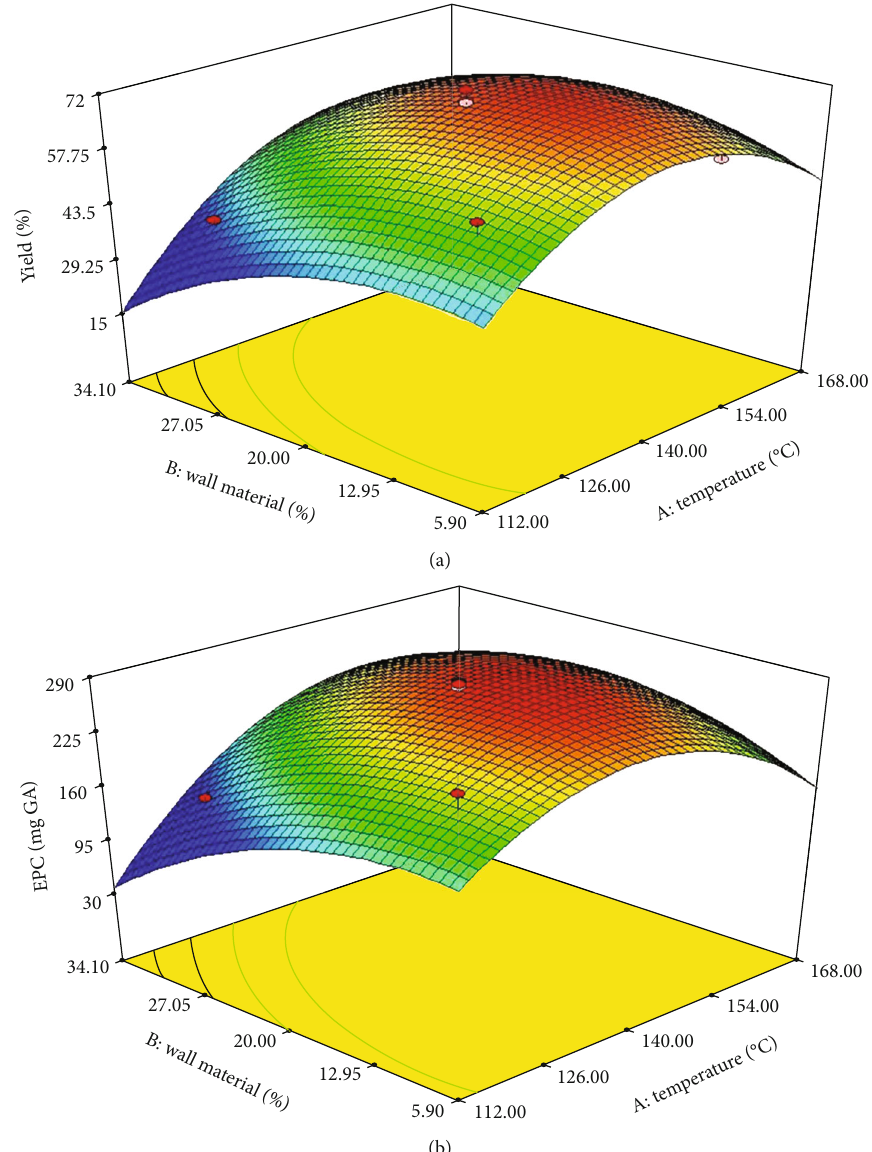
Figure 1: Response surface for (a) yield (%) and (b) encapsulated phenolic compound in microencapsulated oregano ( Lippia graveolens ) extracts. Table 7: Content of encapsulated phenolic compounds and antioxidant capacity of microencapsulated oregano ( Lippia graveolens ) extracts. TPC Sample (mg GAE/g sample) Optimized